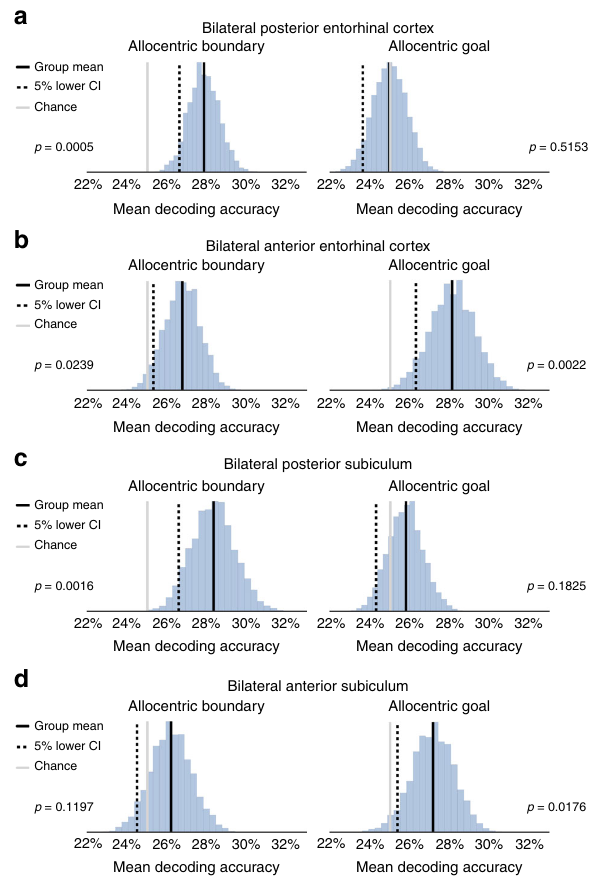
Fig. 2 fMRI decoding results in bilateral EC and subiculum. a Using a linear SVC with L2 regularisation, in bilateral posterior EC group decoding accuracy for allocentric boundary direction was signi fi cantly above chance, as determined by a boot-strap permutation test (10,000 samples). It was not possible, however, to decode allocentric goal direction. b In anterior EC, we were able to decode both allocentric boundary and goal direction. c The posterior subiculum contained similar information to the posterior EC, in that we could decode allocentric boundary, but not goal, direction. d Finally, in anterior subiculum it was possible to decode allocentric goal, but not boundary, direction. All p values were determined via non-parametric Monte Carlo signi fi cance tests. Source data are provided as a